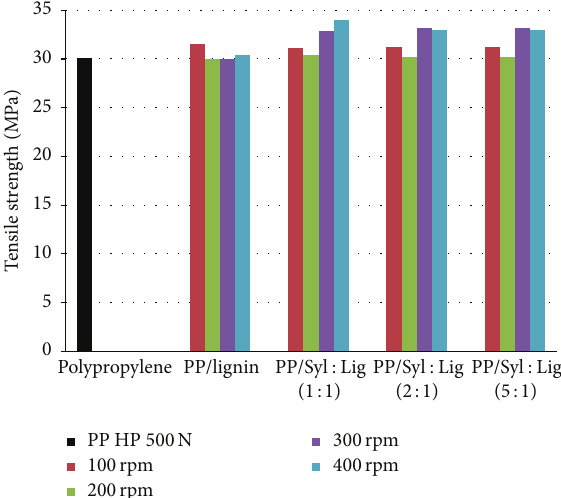
Figure 7: Thermal degradation curves versus temperature for pure PP and its blends with hybrid filler containing 20% of lignin, made with 100 and 400 rpm of screw speed respectively.